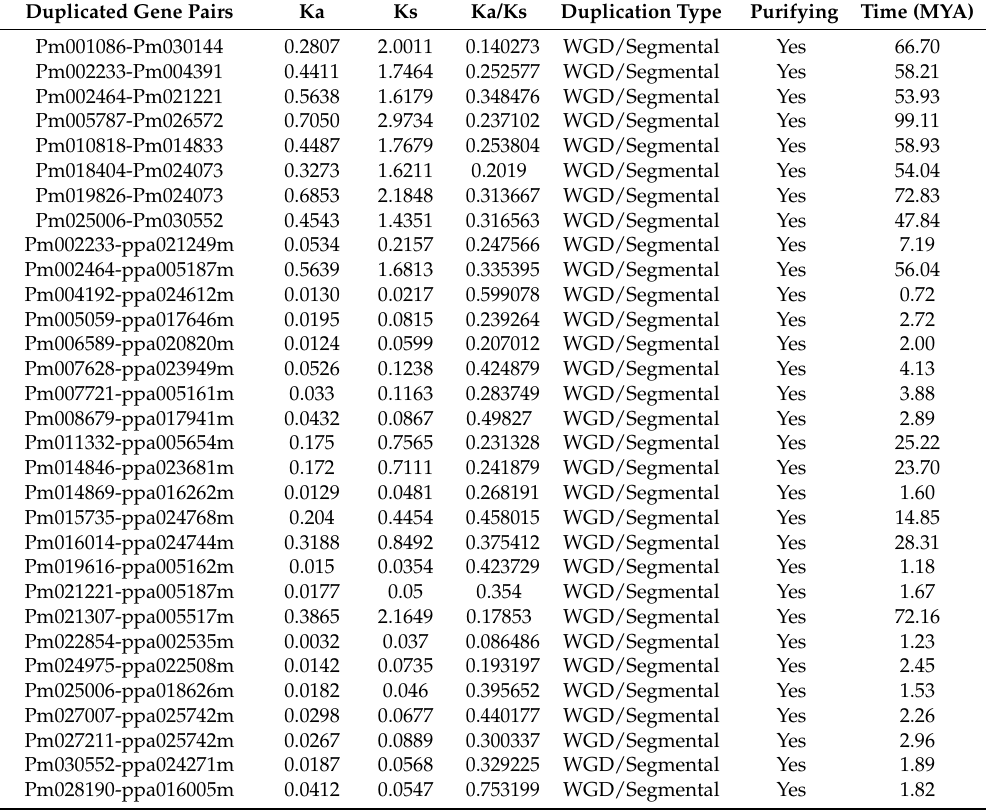
Table 1. Calculation of Ka/Ks and the divergence time of the duplicated UGT gene pairs in P. mume and P. persica